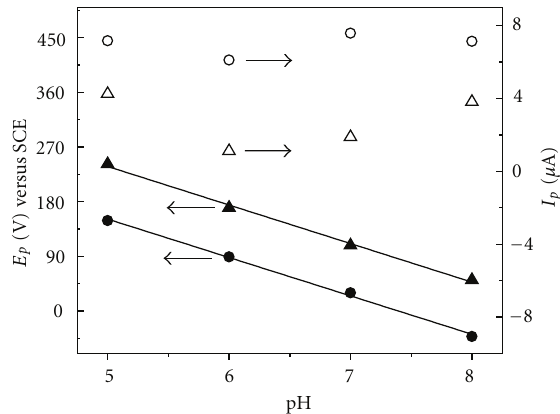
Figure 4: Plots of peak potential, E p , and peak current, I p , versus pH from DP voltammograms of CD and BS (concentrations 100 µ M) in 0.1M PBS at MWCNT/PNB-modified electrodes. Triangles indicate CD and circles BS; filled symbols refer to E p and unfilled ones to I p